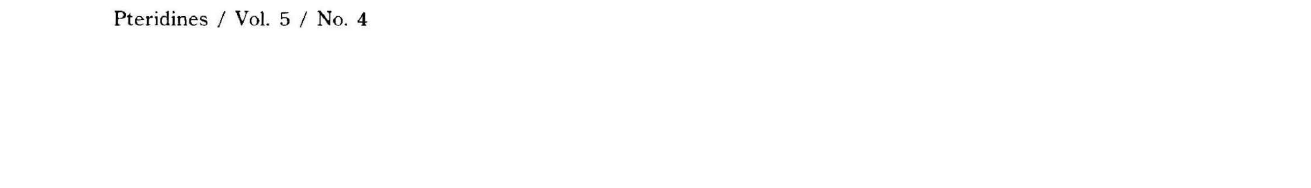
acetic anhydride gave two colorless isomers identical with the products formed as main components in the previous experiment. Figure 3. UV -spectra of 1(--), 3( - - -) and 5-acetyl-5, 6,7,8-tetrahydro-1,3-dimethyllumazine ( .. , ... ) in MeOH, tat ion the coupling of one of the diastereotopic H-C (7A) with the adjacent H-C (6) and the N-H,